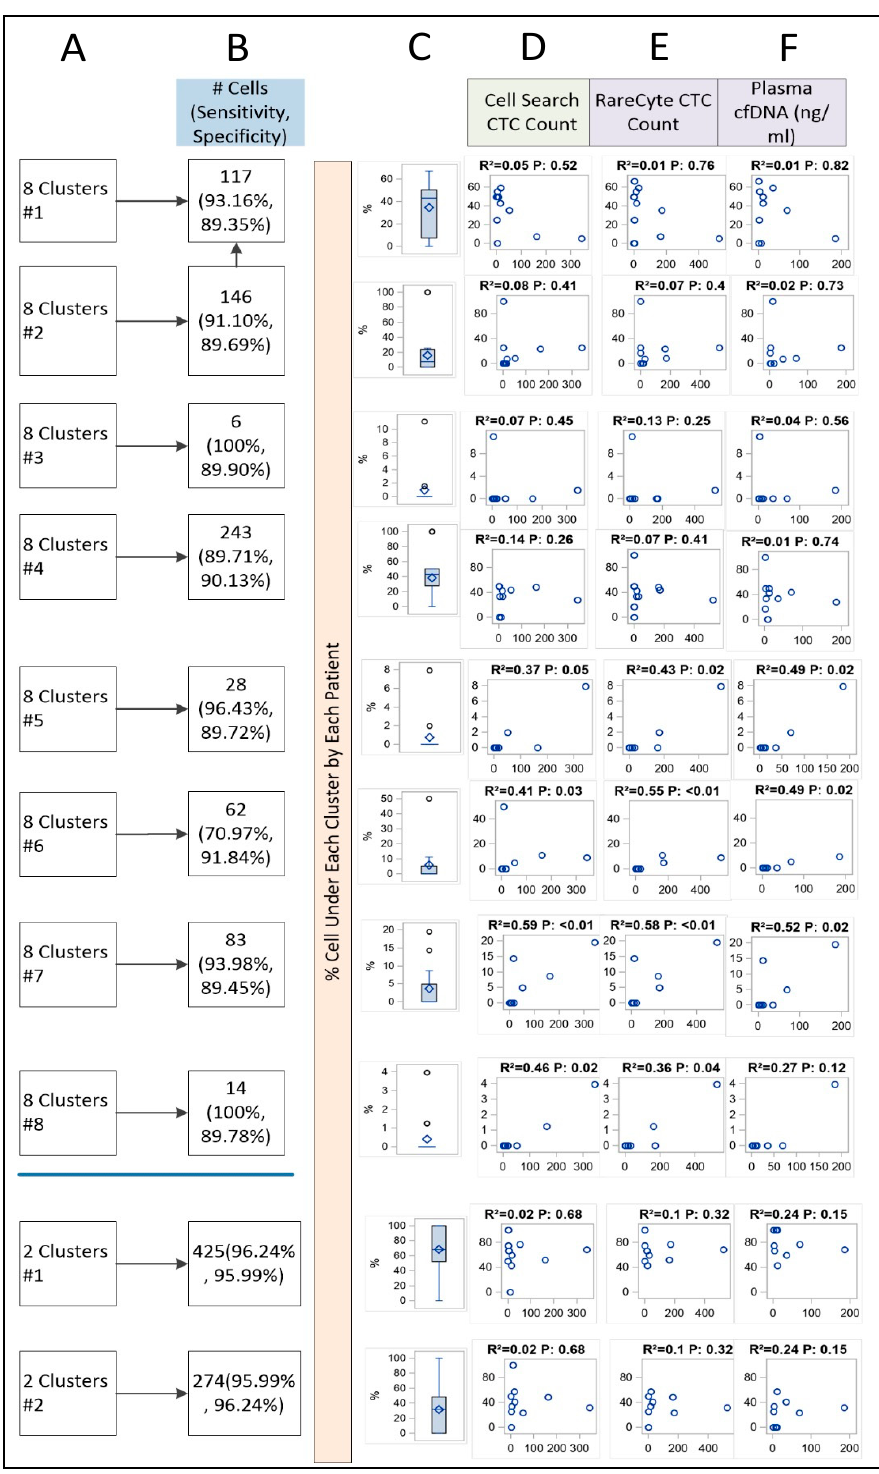
Figure 5. Correlation between Cell Cluster Concentration, CTC Count, and cfDNA. Column A : Cluster label. Column B : Number of CTCs and prediction accuracy (sensitivity/specificity) when using morphological features to predict clusters identified by K-means machine learning. Column C : Distribution of percent CTC from each patient that fell into a given cluster. Column D – F : Correlation between percentage of cell count under a given cluster within an individual and total CTC numbers and cfDNA level at the patient level.